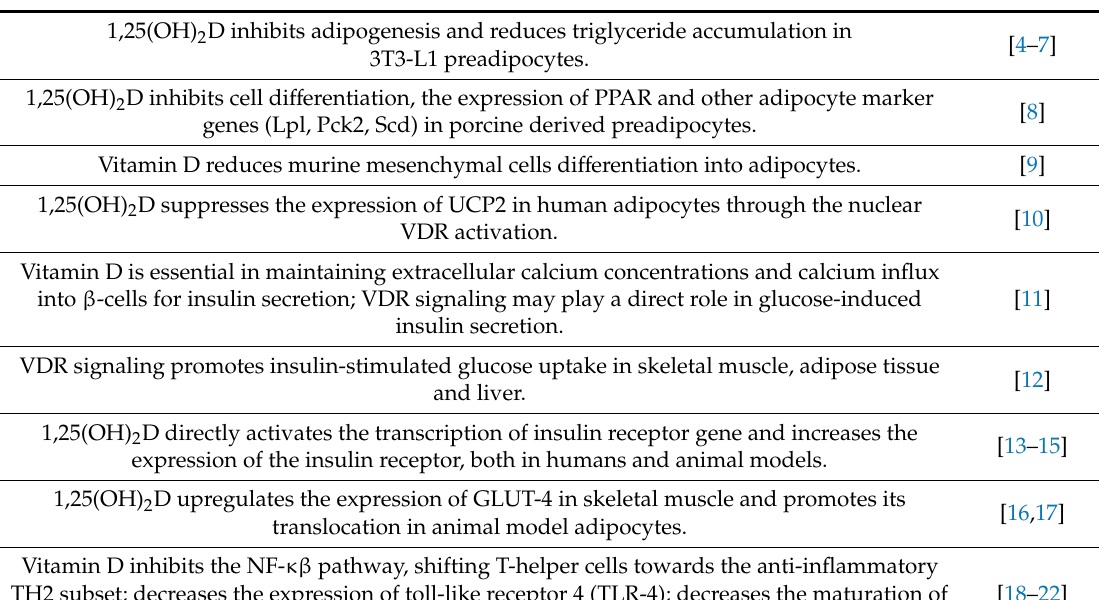
vitamin D modulates insulin sensitivity and glycemic control in obese individuals. VDR: vitamin D receptor. Table 1. Principal biological mechanisms by which vitamin D modulates adipogenesis and glucose homeostasis in humans, animal and cellular models. 1,25(OH) 2 D inhibits adipogenesis and reduces triglyceride accumulation